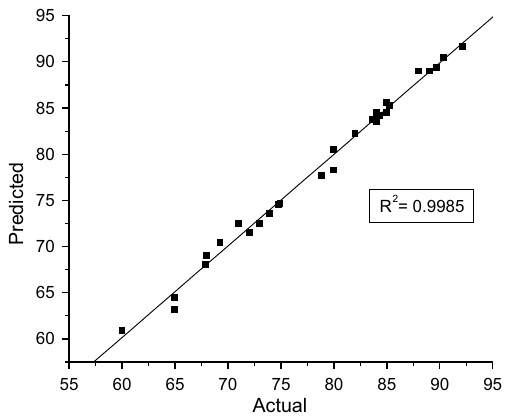
Fig. 2 Comparison of the experimental data (line) with those pre- dicted data (symbols) of carbaryl adsorption onto